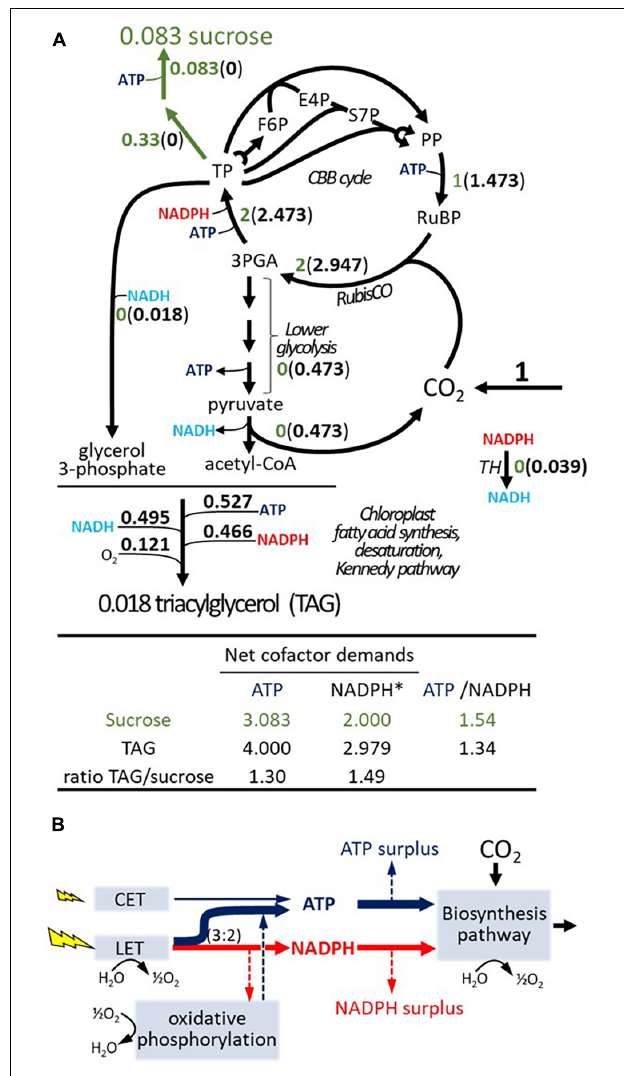
FIGURE 2 | Basic stoichiometries for sucrose and TAG synthesis and cellular energy cofactor budget. (A) Stoichiometries for the assimilation of CO 2 via the Calvin–Benson–Bassham (CBB) cycle into sucrose (green shading) or TAG based on balancing a generic plant stoichiometric model (see Supplementary File 3 ) with fatty acid composition of TAG as in iTJC1414x4 . Flux values are normalized relative to one mol of CO 2 net assimilation. Oxygen consumption shown for TAG synthesis is due to fatty acid desaturase reactions. (B) Balance of ATP and NADPH between supply (photosynthetic light reactions) and demands (biosynthetic pathway). In modeling scenarios, the light reactions are thought to supply ATP and NADPH at a fixed ratio. If